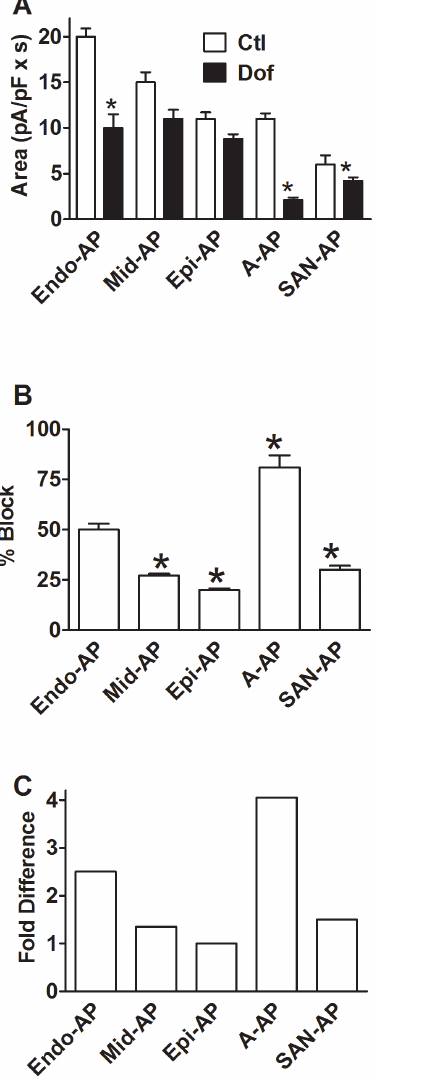
Figure 9. Pharmacological property of I HERG reported by AP- clamp. A , effects of I Kr /HERG blocker dofetilide (Dof, 10 nM) on I HERG with AP waveforms of various regions. * p , 0.05 vs. Ctl (n=18 cells). B , % block of I HERG over control by dofetilide with AP waveforms of various regions. * p , 0.05 vs. Endo-AP (n=18 cells). C , Fold difference of I HERG blockade by dofetilide with AP waveforms of various regions. Data were normalized to the value with Epi-AP.